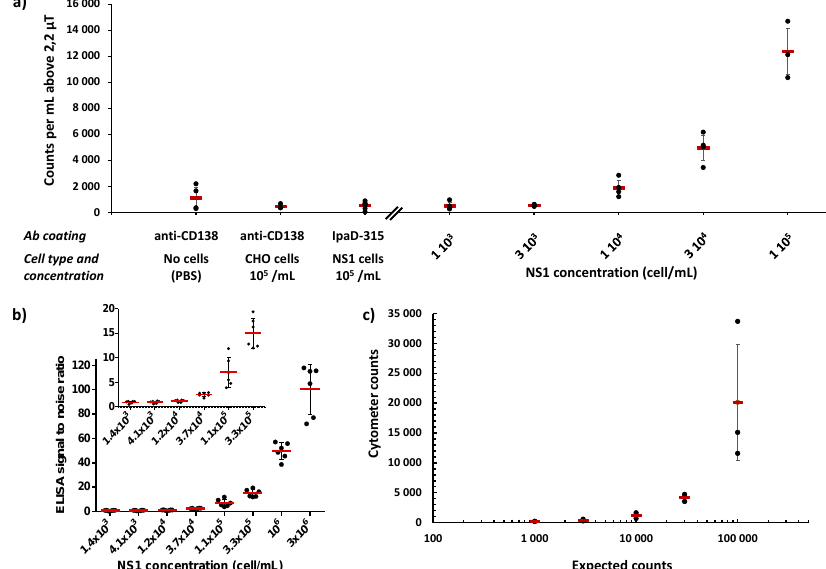
Figure 6. Experimental results of the three tests. All were performed in different days, thus the same samples were not tested with the three techniques. ( a ) Experimental results of the GMR test. Red dashes represent the mean of the experiments. Error bars represent standard deviations from the experiments. ( b ) Experimental results of the ELISA tests. Different concentrations of NS1 cells in PBS were detected using the homologous sandwich ELISA involving anti-CD138 mAb as capture and tracer antibody in a 5 h sequential format. The signal to noise ratio was calculated from the mean of eight measurements of PBS alone. Red dashes represent the mean of the three independent experiments, each performed in duplicate. Error bars represent standard deviations from the three experiments. The insert shows the low concentration part of the curve. ( c ) Experimental results of flow cytometry presented as counts per milliliter for each concentration. Red dashes represent the mean of the three independent experiments. Error bars represent standard deviations from the three